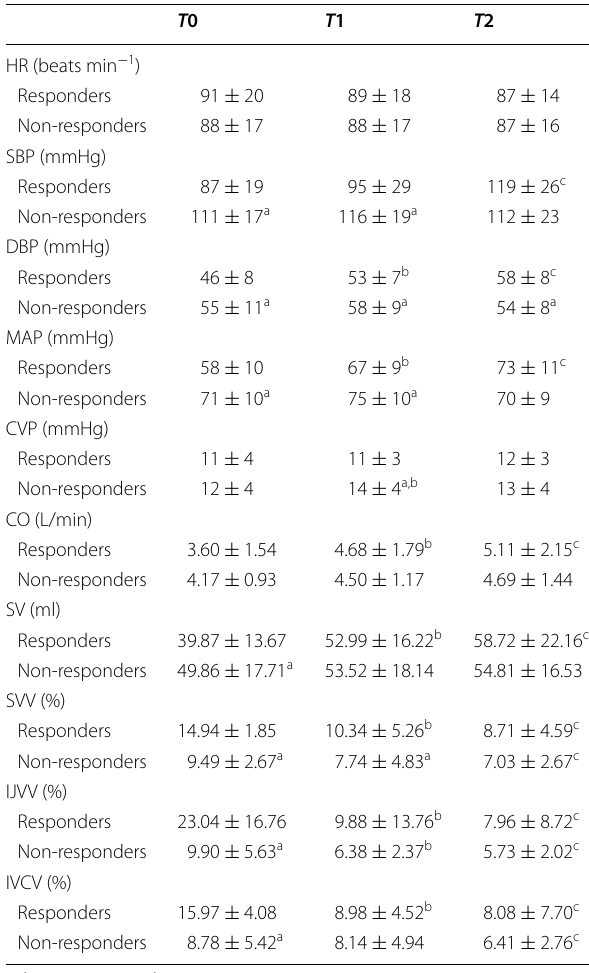
Table 2 Hemodynamic parameters measured in respond- ers and